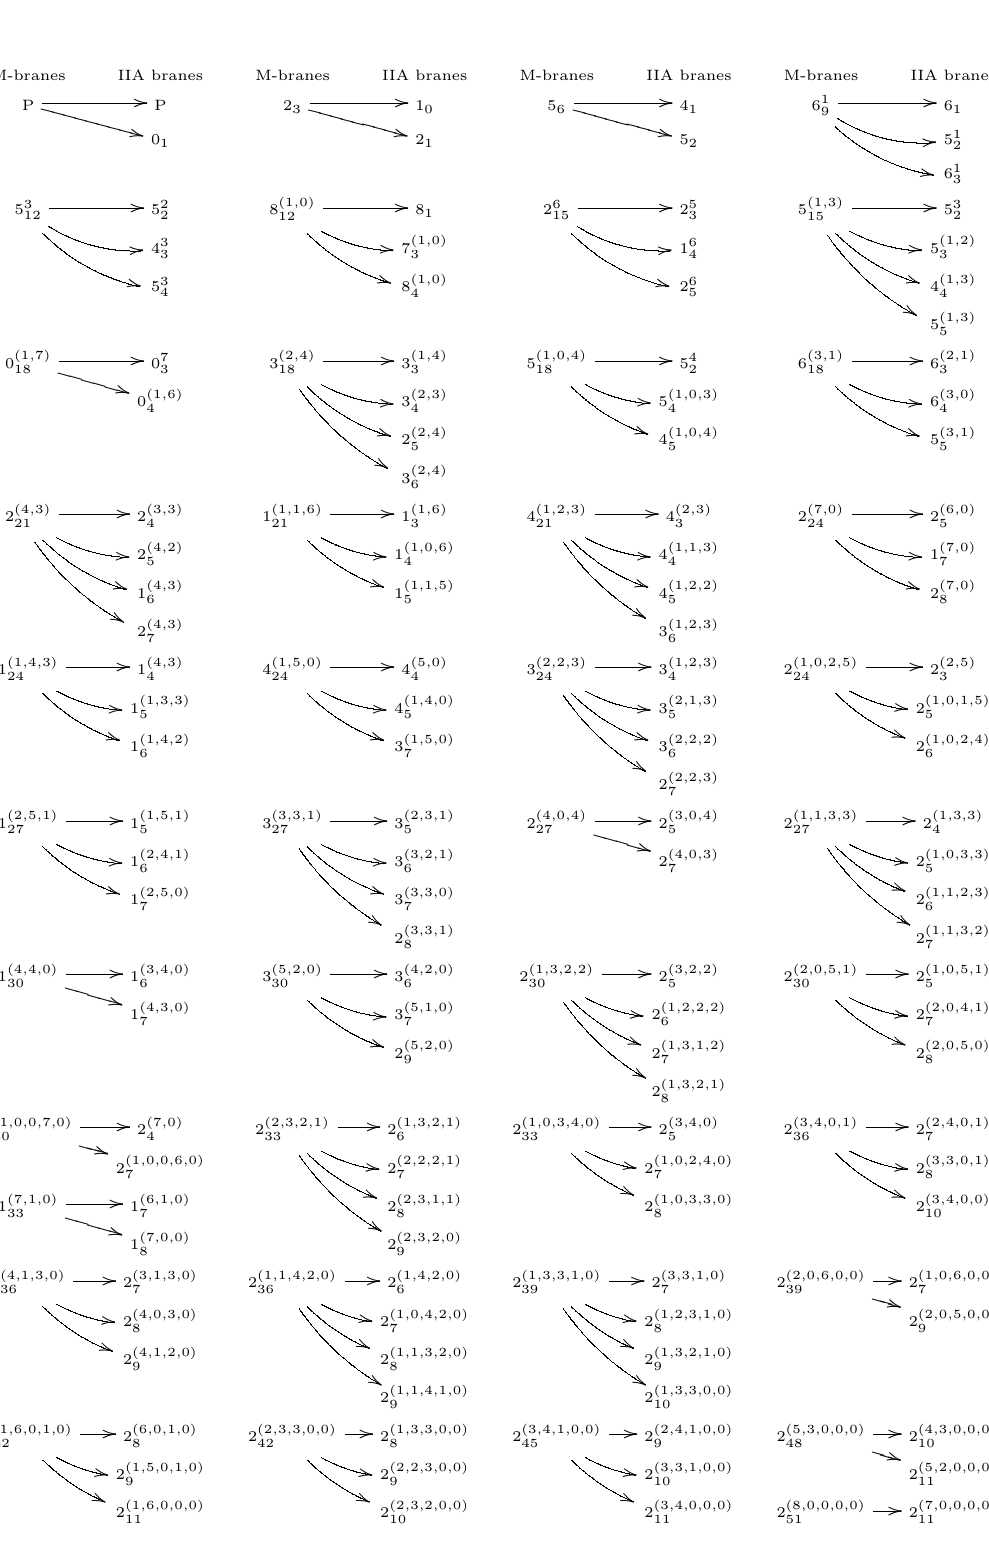
Table 4 . A map between branes in M-theory and type IIA